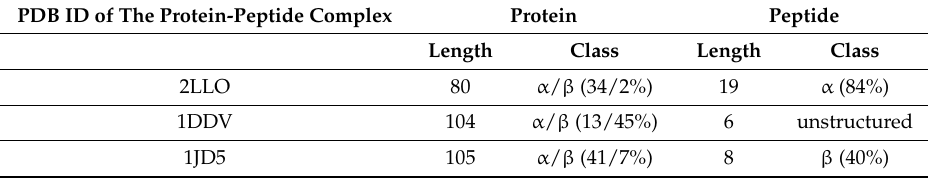
Table 2. List of 3 complexes used in the all atom SMD simulations. The bound structures of the complexes are obtained from the structures deposited in Protein Data Bank. The lengths and structural classes of both the proteins and the peptides are